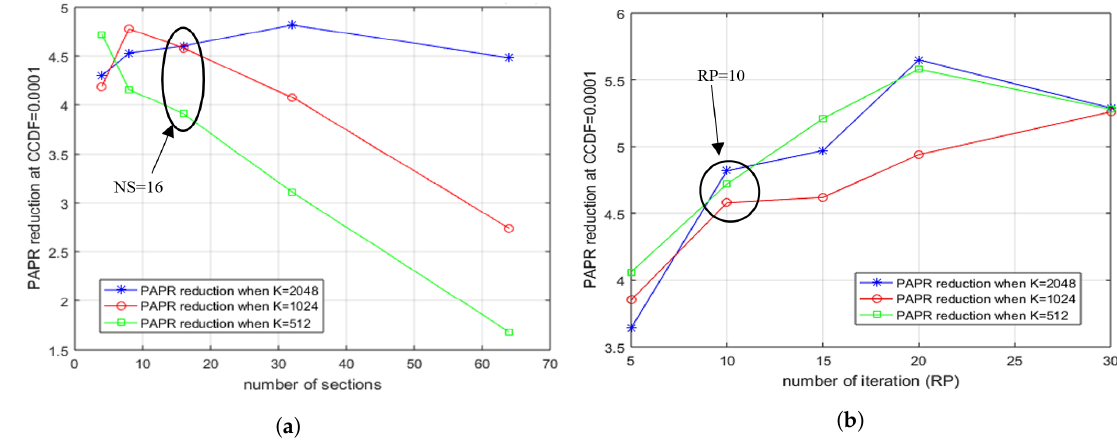
Figure 9. ( a ) PAPR reduction performance variation with NS [24]; ( b ) PAPR reduction performance variation with RP